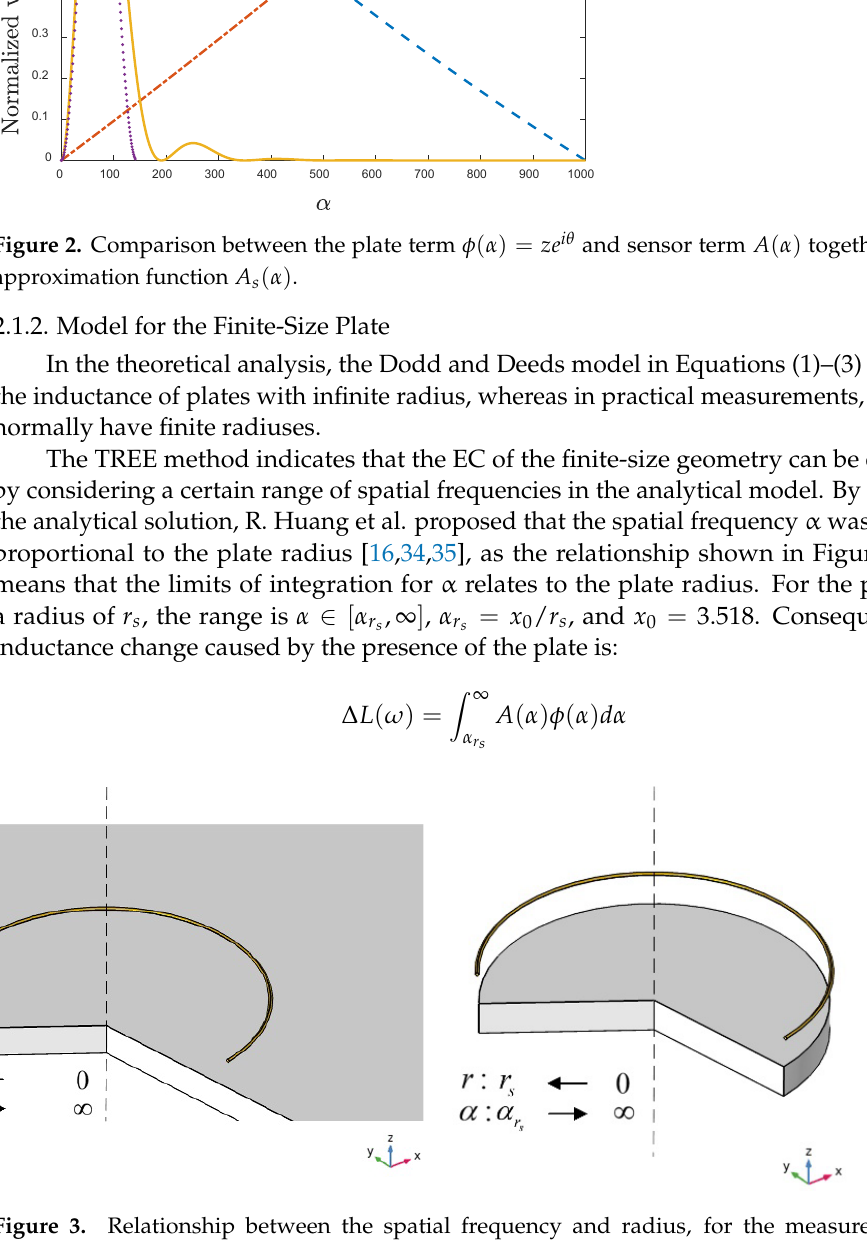
Figure 3. Relationship between the spatial frequency and radius, for the measurement of a finite-size plate.